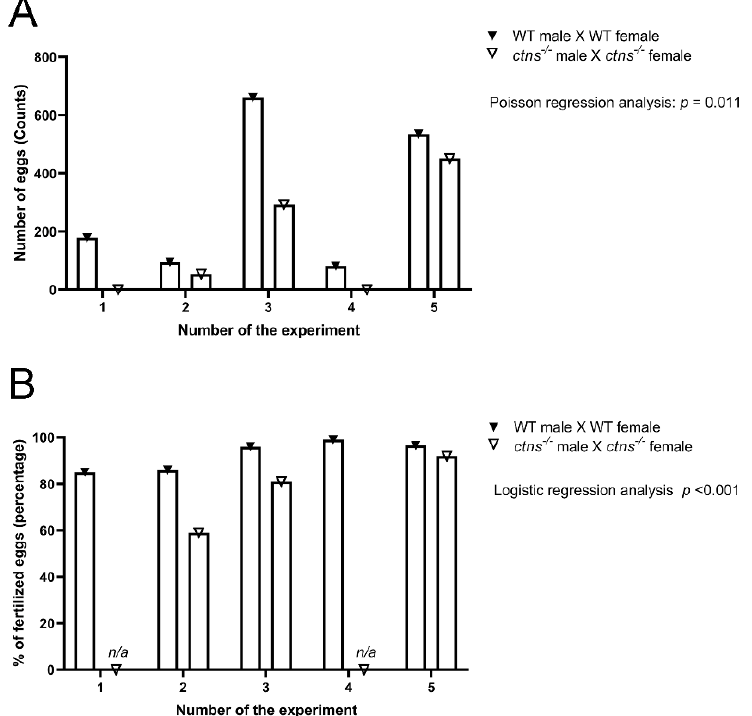
Figure 8. Egg production and percentage of fertilized eggs in wild-type and ctns − / − zebrafish. ( A ) Egg production was measured as a total number of eggs in wild type and ctns − / − zebrafish 18-month-old zebrafish. The egg production rate is 1.941 high in wild-type zebrafish compared with ctns − / − 18-month-old zebrafish (rate ratio = 1.941); 95% CI (lower bound = 1.165, higher bound = 3.234); Poisson regression analysis; p = 0.011. ( B ) The percentage of fertilized eggs was measured on the total number of eggs. The odds of the fertilized eggs are 3.504 high in wild-type zebrafish compared with ctns − / − 18-months-old zebrafish (odds ratio = 3.504); 95% CI (lower bound = 2.005, higher bound = 6.124); Logistic regression analysis; p < 0.001; n/a : not applicable.